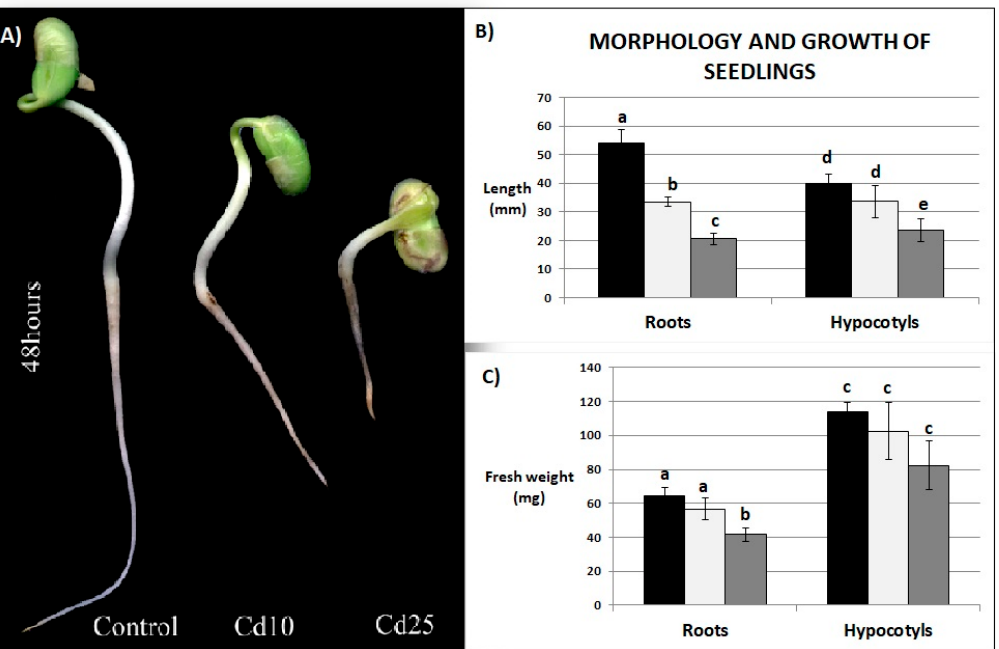
Figure 2. Impact of Cd on seedlings morphology ( A ), roots and hypocotyls length ( B ) and fresh weight ( C ) Black bars—control plants, white bars—plants stressed previously with Cd at the concentration 10 mg/L, dark grey bars—plants stressed previously with Cd at the concentration 25 mg/L. Results are the means of three independent experiments ± SE . Results showing no statistically significant differences in relation to control by p = 0.05 are marked with same letter.